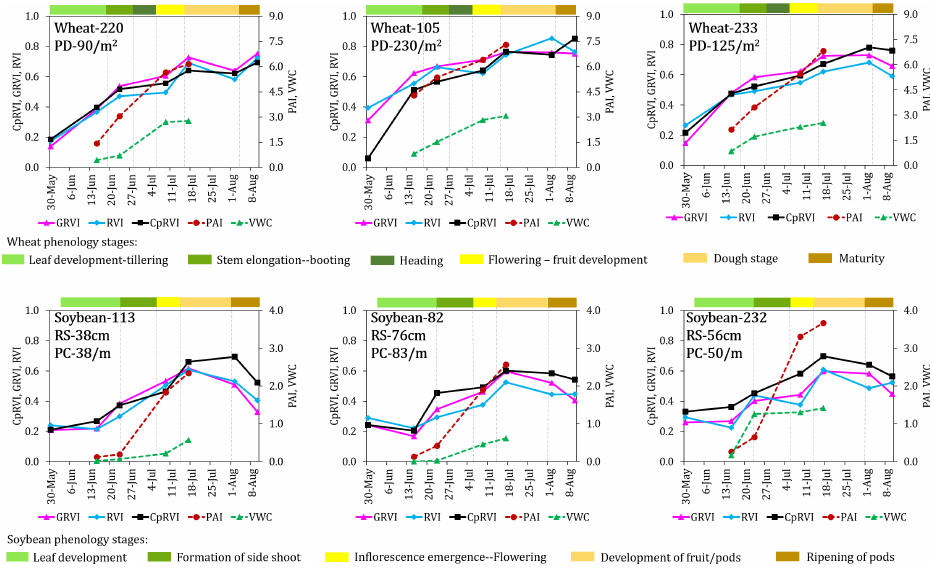
Figure 4. Temporal pattern of vegetation indices (CpRVI, RVI, and GRVI) for wheat and soybean